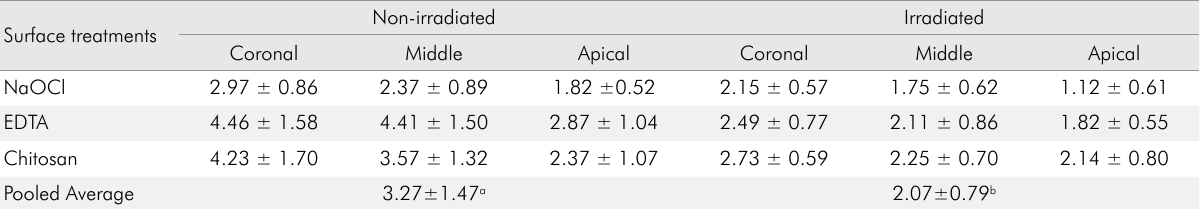
Table 1. Push-out bond strength means (in MPa) of the filling material to root dentin at the different root thirds in specimens subjected or not to radiation therapy with different final irrigation surface treatments.